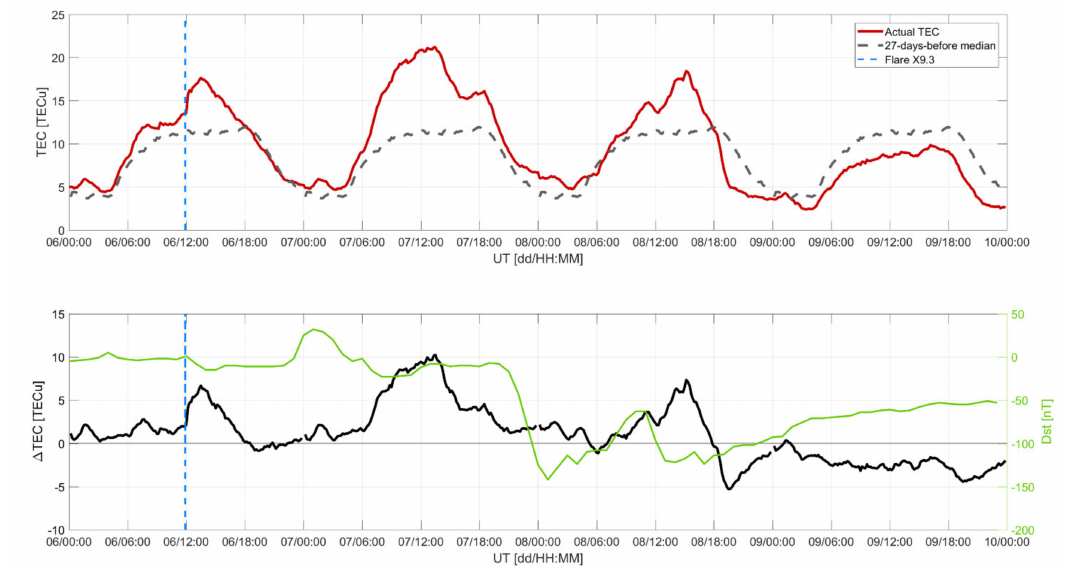
Figure 9. ( Top panel) Mean TEC over Italy for the period 6 September 2017 to 9 September 2017 (red line) and 27-days running median (before the X9.3 flare occurrence) of the mean TEC over Italy (gray dashed line). ( Bottom panel) Difference between actual and median TEC (reported on top panel, black line) and Dst (green line). Blue dashed line indicates the time of the X9.3 flare